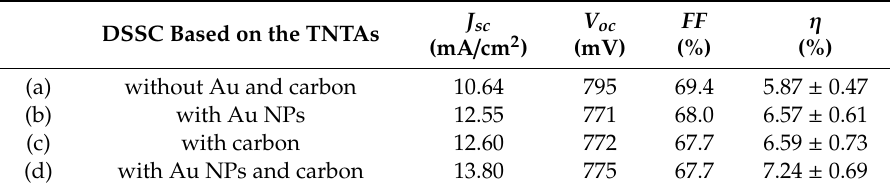
Figure 6. I-V curves of DSSCs based on the freestanding TNTAs ( a ) without Au NPs and carbon materials, ( b ) with Au NPs, ( c ) with carbon materials, and ( d ) with Au NPs and carbon materials. Table 1. Photovoltaic properties of DSSCs based on freestanding TNTAs with / without Ag NPs and / or carbon